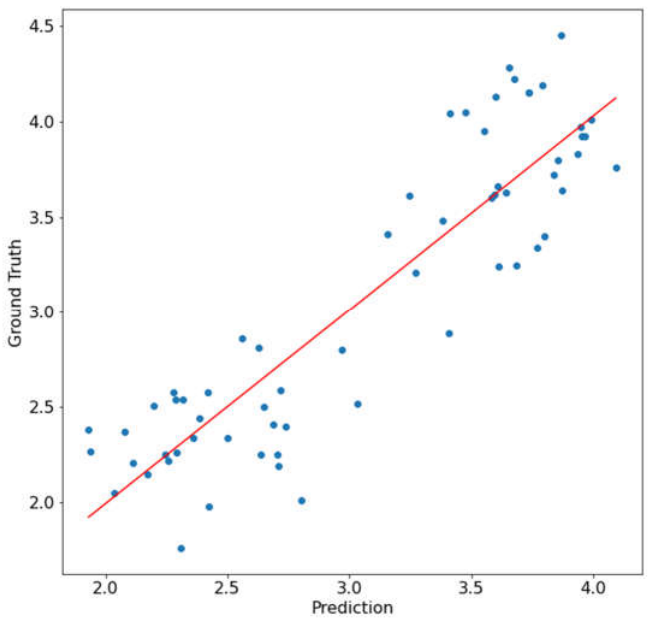
Figure 7. Correlation between N prediction and ground truth data using the mean NDVI modeling.